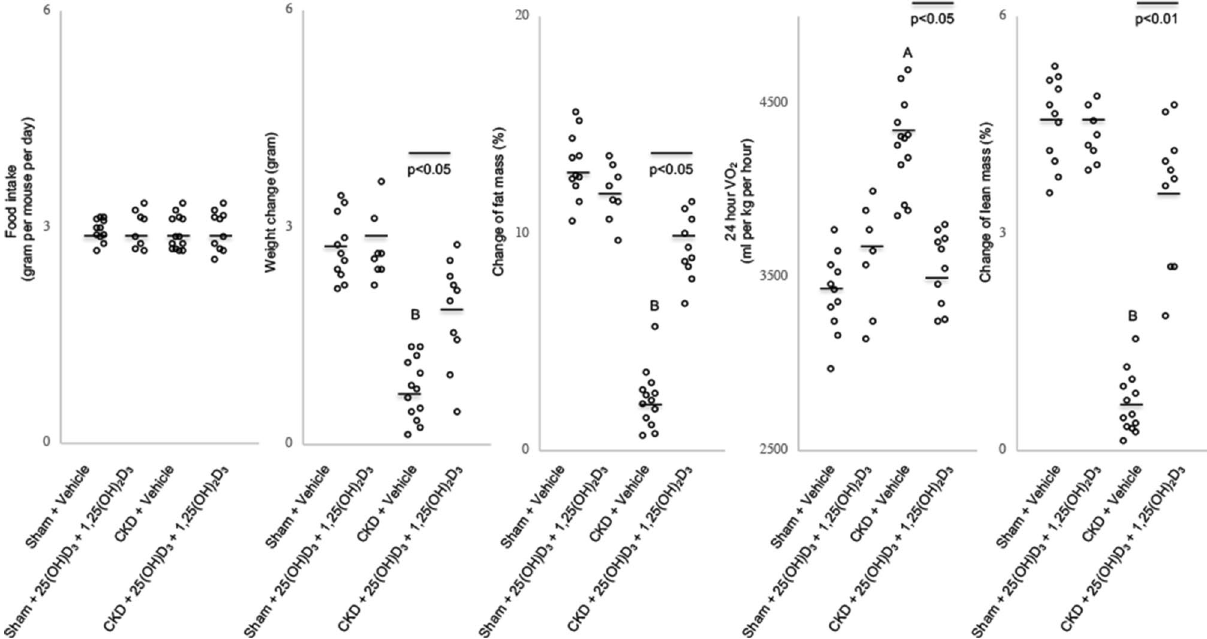
Figure 1. Supplementation of vitamin D ameliorates cachexia in CKD mice. Sham and CKD mice were treated with 25(OH)D 3 and 1,25(OH) 2 D 3 (75 μg/kg per day and 60 ng/kg per day, respectively) or ethylene glycol as vehicle for 6 weeks. Four groups of mice were included: Sham + Vehicle (n = 11), Sham + 25(OH) D 3 + 1,25(OH) 2 D 3 (n = 8), CKD + Vehicle (n = 13) and CKD + 25(OH)D 3 + 1,25(OH) 2 D 3 (n = 10). Data are expressed as mean ± SEM. A p < 0.05, significantly higher in CKD + Vehicle and CKD + 25(OH) D 3 +1,25(OH) 2 D 3 mice versus Sham + Vehicle and Sham + 25(OH)D 3 + 1,25(OH) 2 D 3 mice, respectively. B p < 0.05, significantly lower in CKD + Vehicle and CKD + 25(OH)D 3 + 1,25(OH) 2 D 3 mice versus Sham + Vehicle and Sham + 25(OH)D 3 + 1,25(OH) 2 D 3 mice, respectively. Results of CKD + Vehicle mice were also compared to CKD + 25(OH)D 3 + 1,25(OH) 2 D 3